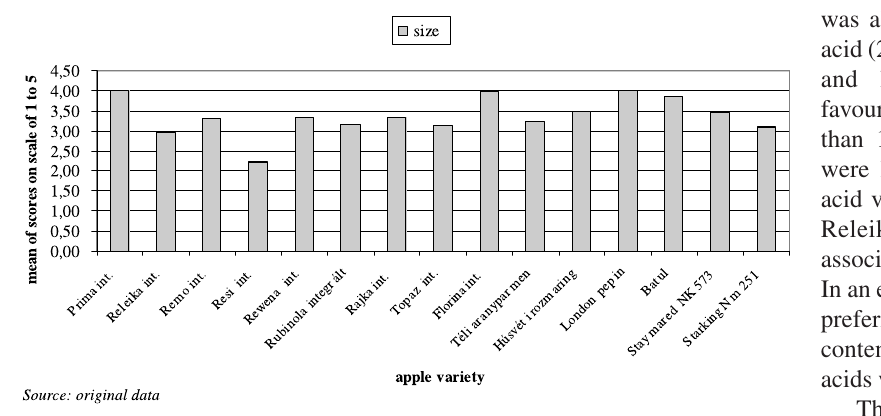
Figure 2: Scores related to the size of fruits